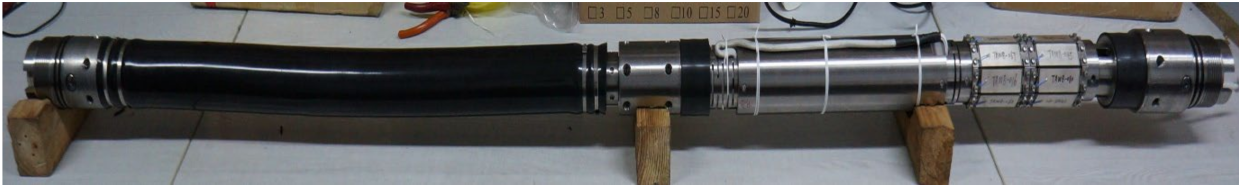
Figure 4. Internal actual picture of an acoustic sonde composed of an azimuthal-transmitting arc